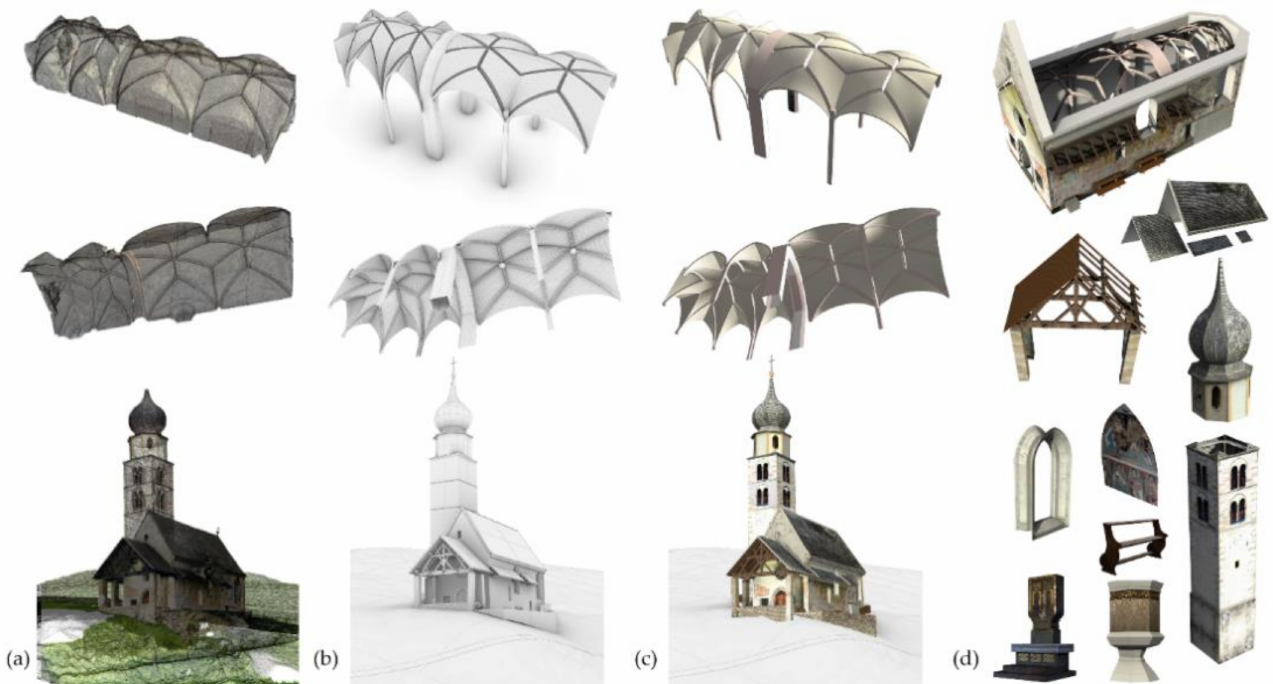
Figure 8. The scan-to-BIM process applied to the research case study: from digital photogrammetric model ( a ), NURBS model by GOGs ( b ), NURBS model ( c ) to HBIM textured objects ( d